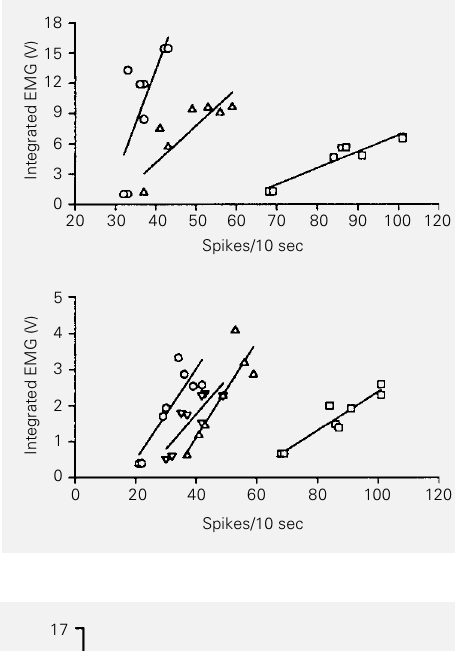
Figure 2 - Fine relationship be- tween the electrical activity of putative serotonergic neurons and the integrated electrical ac- tivity of the digastric muscle (top panel) and the splenius muscle (bottom panel). Six 10-sec samples were taken during feed- ing behavior (drinking milk). p , neuron #14171; # , neuron #24151. In both cases the corre- lation was significant at the 0.04